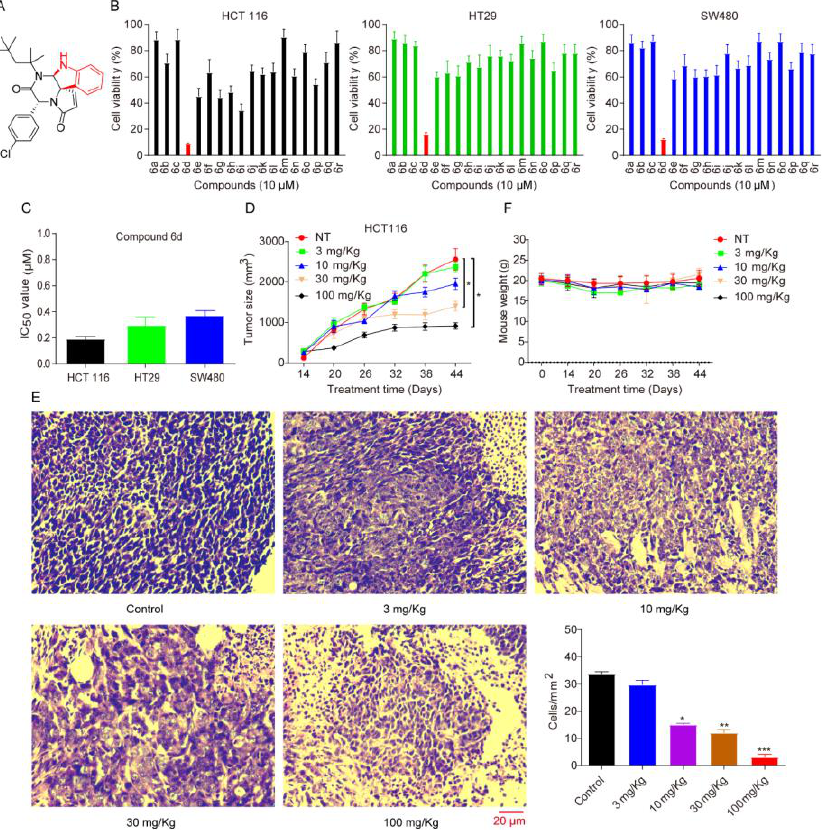
Figure 1. Spiroindoline compound 6d decreases the viability of CRC cell lines. ( A ) The chemical structure of compound 6d . ( B ) The bioactivity of compound 6d was assessed by MTT in CRC cells, including HCT116, HT29 and SW480. These cells were treated with compound 6d at 10 μM for 48 h, respectively, and then cell viability was measured. Data were the mean ± SD of three independent experiments, and each experiment was conducted in sextuplicate. ( C ) The IC 50 value of compound 6d was measured and calculated in CRC cell lines. ( D ) SCID/Nude mice bearing HCT116 tumor xenografts were administrated with or without compound 6d by intraperitoneal manner. Mean tumour volume or weight ± SD was shown; n = 6 mice per group. ( E ) Representative images of hematoxylin and eosin (H&E) staining in HCT116-induced tumor xenografts. Scale bar indicates 20 μm. ( F ) The body weight of the mice from each group was not remarkably influenced by the compound 6d treatment, suggesting that there was no significant toxicity. All data are presented as the mean ± SD of three independent experiments. * p < 0.05; ** p < 0.01; and *** p < 0.001 versus